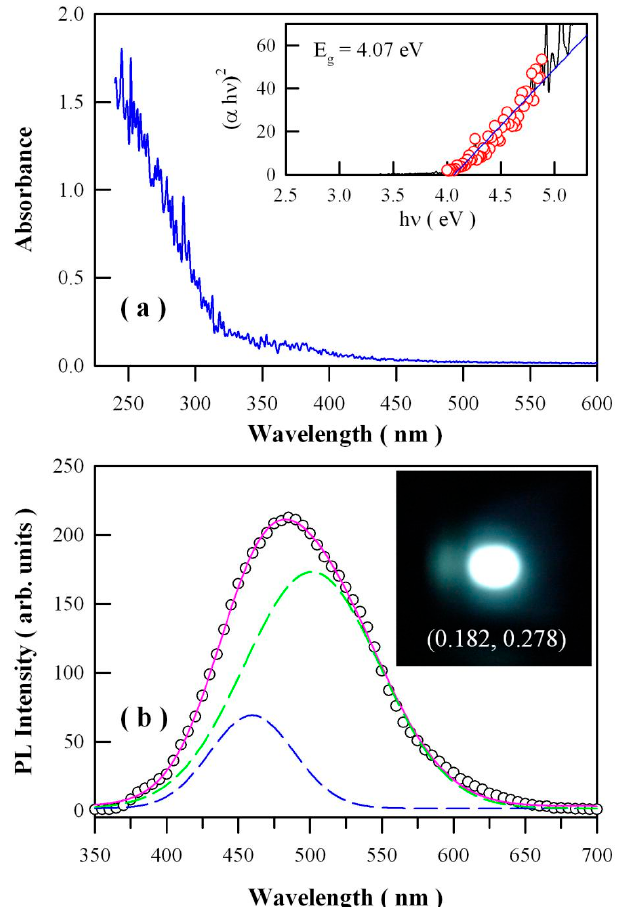
Figure 6. Ultraviolet–visible light (UV–Vis) absorption spectrum ( a ) and photoluminescence (PL) spectrum ( b ) of ZnWO 4 nanoplates. The Tauc plot and luminescence photo are shown as insets for the ZnWO 4 nanoplates.